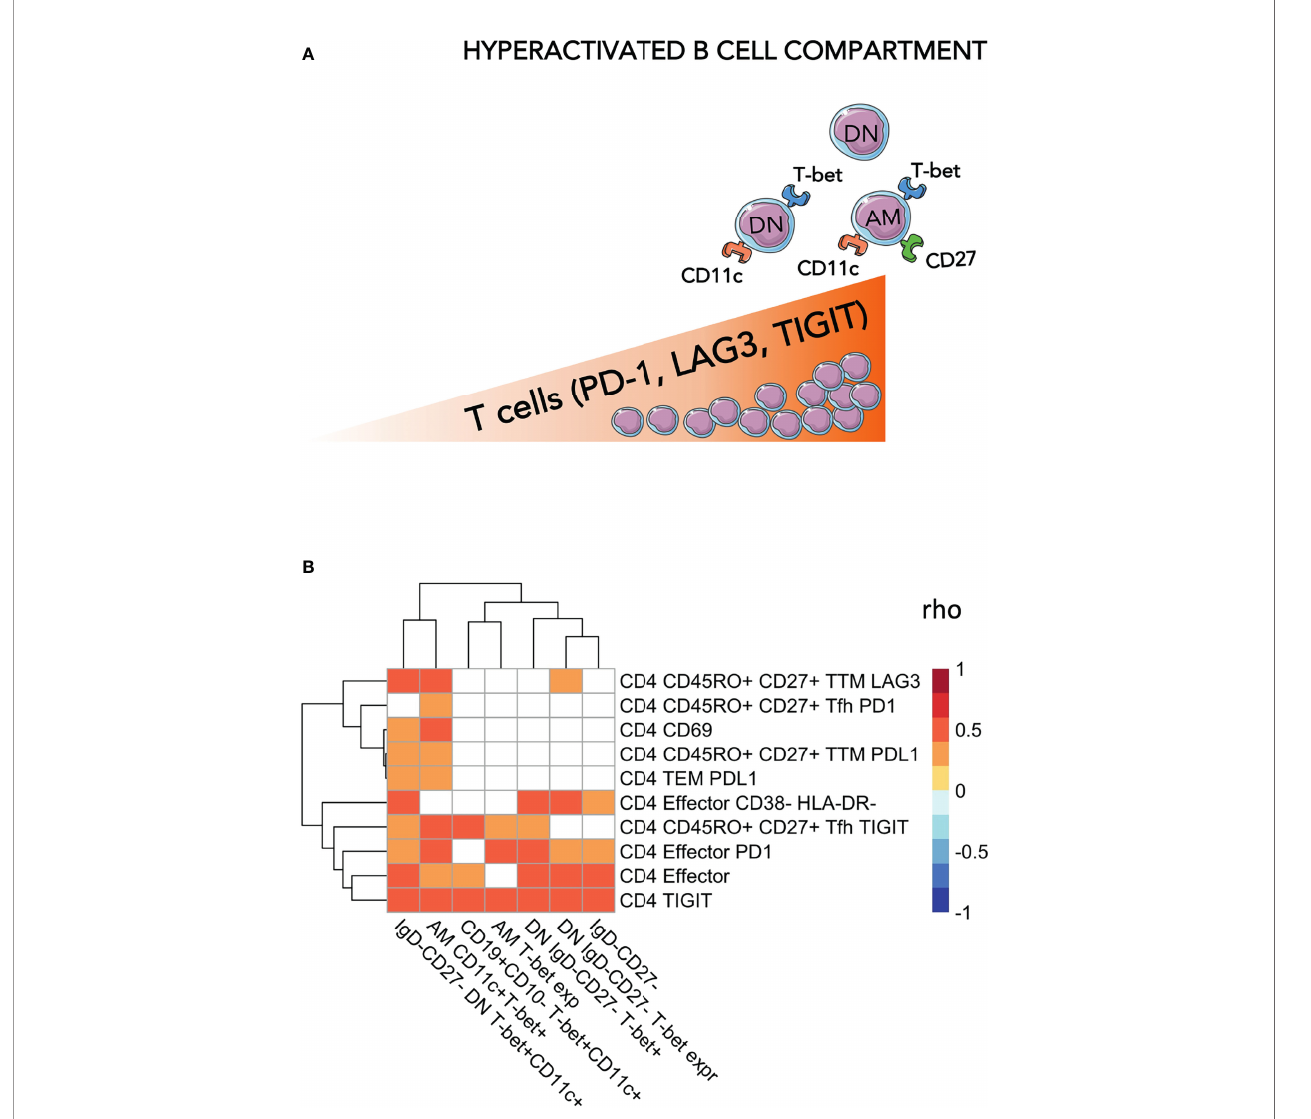
FIGURE 2 | Levels of exhausted T-cells are positively associated with hyperactivated B-cells. In (A) a cartoon showing the main fi ndings of the fi gures are pictured. In (B) Heatmap plot showing Spearman correlations between exhausted T-cells and hyperactivated B-cells. Only signi fi cant correlations are shown with red indicating positive correlations and Blue the negative ones. The colored scale going between 1 and -1 indicates the rho values. DN, double negative; AM, activated memory. Signi fi cance was set at